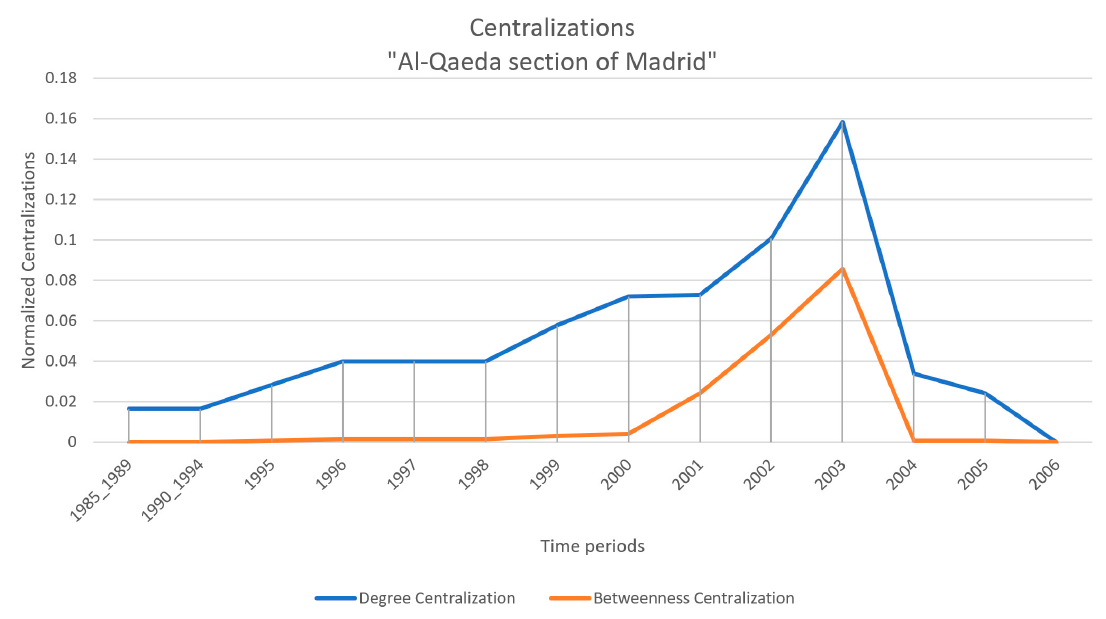
Figure 11. Temporal development of degree and betweenness centralizations for the “Al-Qaeda section of Madrid”. Both indices increase, reach a maximum in 2003, and then decrease. In the period 2000–2001, degree centralization reaches a small plateau, while betweenness centralization increases. Both indices rapidly decrease after 2003.